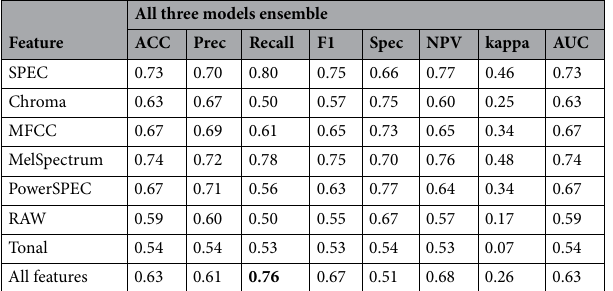
Table 11. The performance of ensemble model classification per feature for all classifiers. Bold value indicates best performance of the classifiers.